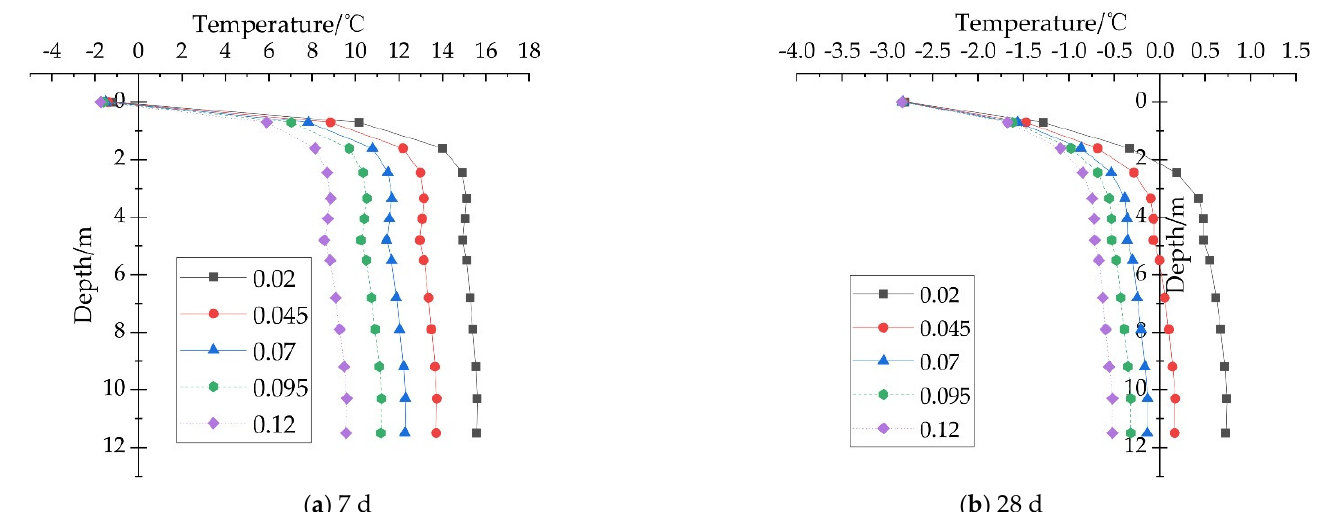
Figure 10. Effect of thermal conductivity on the temperature of pile foundation.